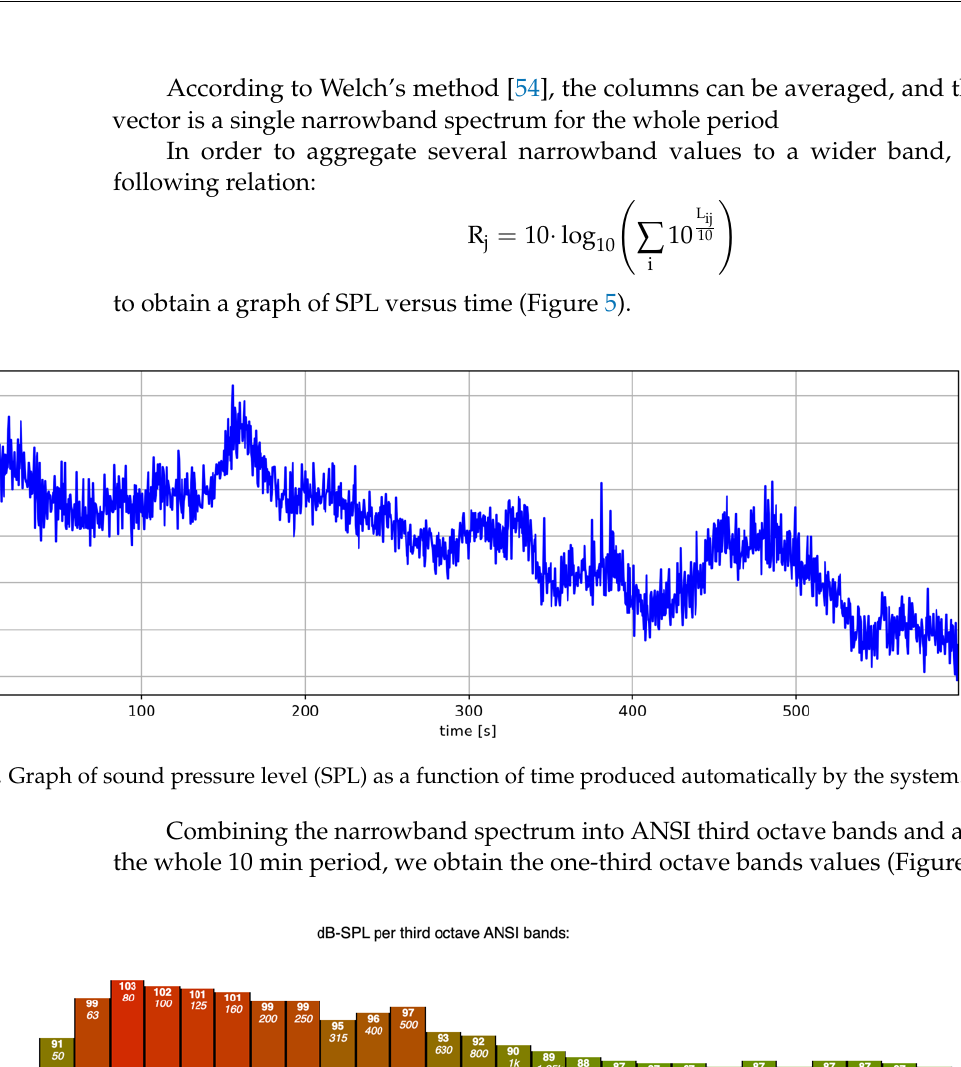
Figure 4. Spectrogram of a 10 min recording produced automatically by the system; it is possible to notice the movement of a noise source (very likely a small boat).